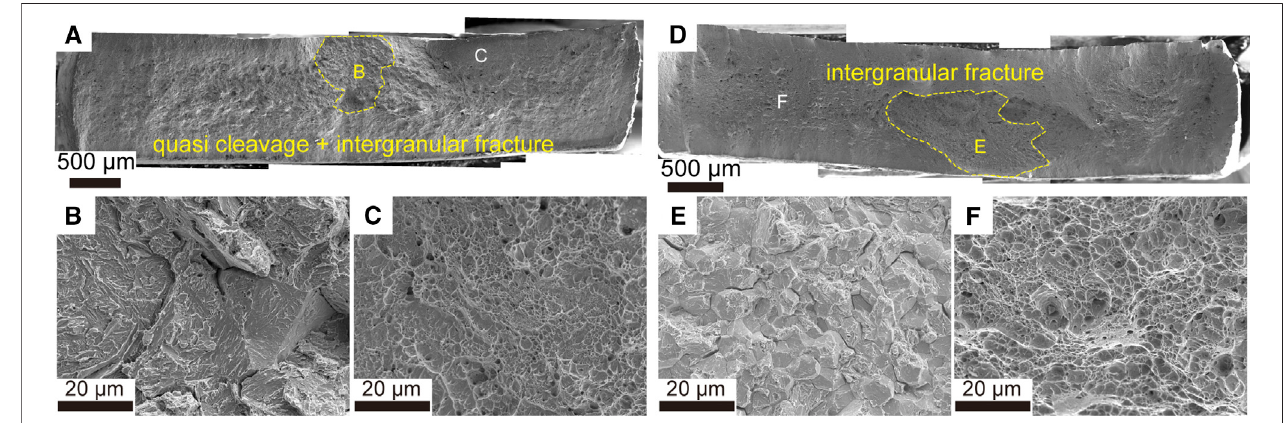
FIGURE 9 | Fractography of SSRT tests on (A) – (C) the 22MnB5 steel and (D) – (F) the 34MnB5V steel, both of which (with zinc coating) had been charged and naturally aged for 24 h.